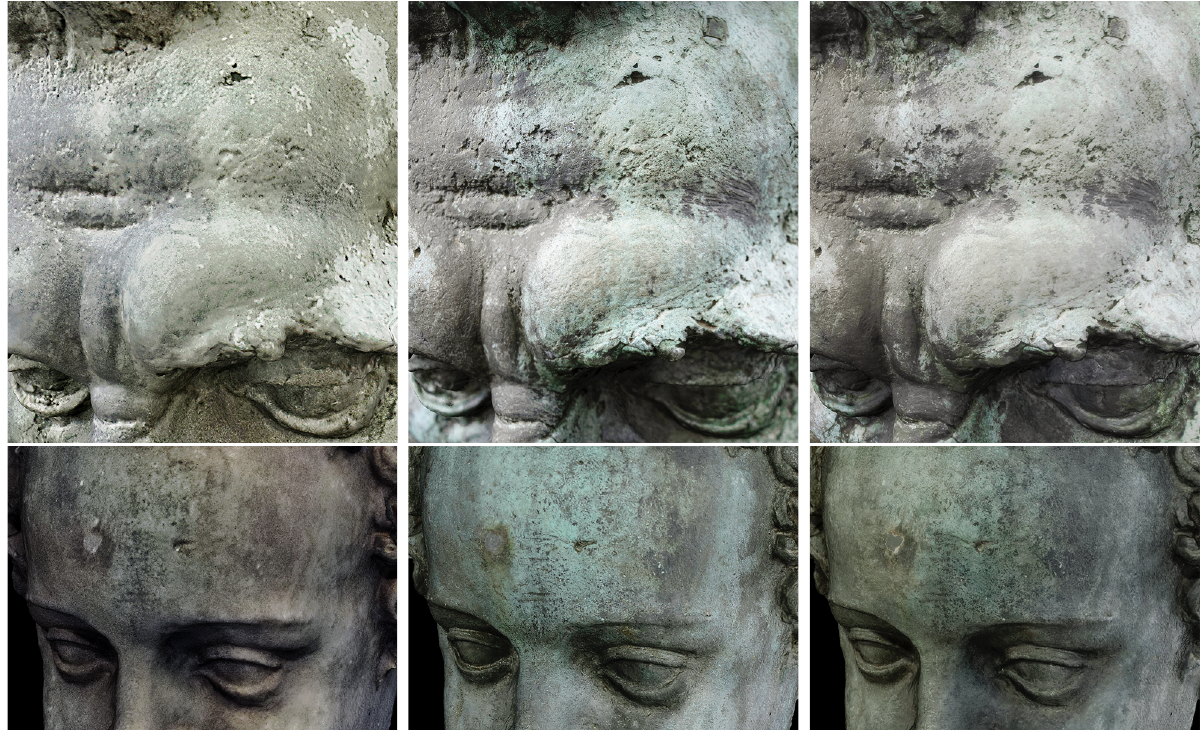
Figure 2. The result of our workflow: above the Neptune head and below the female Putto before cleaning and in two different cleaning phases, from left to right.